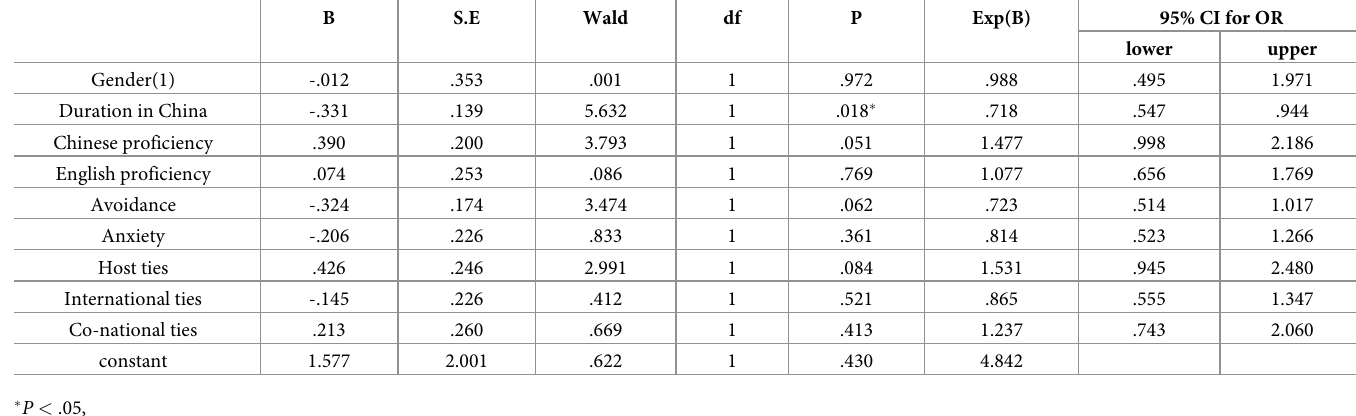
Table 3. Logistic regression predicting likelihood of adopting separation